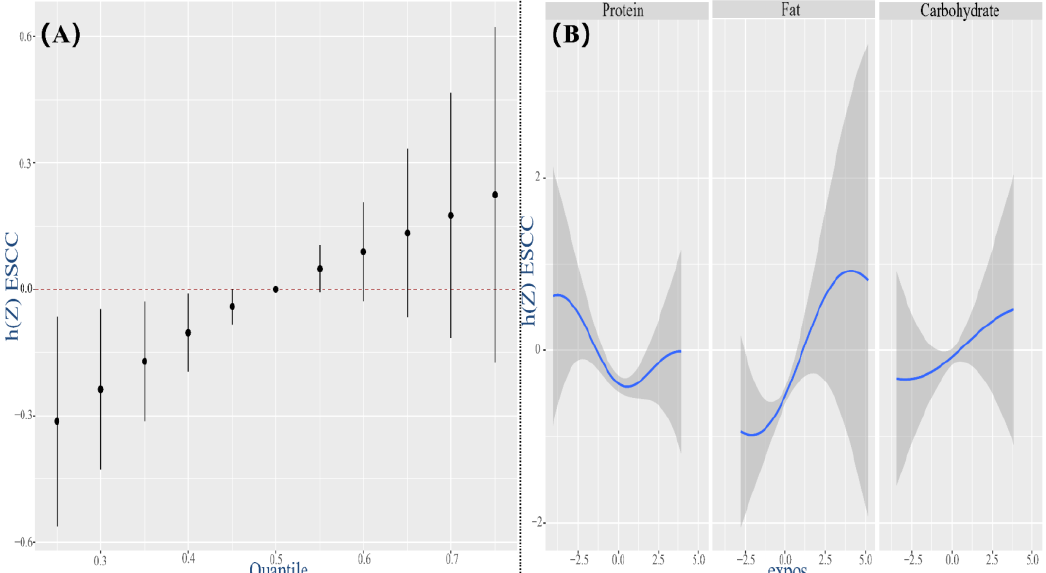
Figure 4. Associations between three pro−inflammatory nutrients (predictors) and ESCC (outcome) by BKMR model adjusting for age, gender, education, income, occupation, tobacco smoking, drinking intensity, tea consumption, eating speed per meal and hot food. ( A ) The estimated overall effect of 13 dietary nutrients as compared to when all other nutrients are at the 50th percentile. The red dotted line means the reference level at which all of nutrients are fixed to their 50th percentile, to achieve interests of computing the overall effect of the mixture. ( B ) The univariate exposure–response function of each nutrient when setting the remaining nutrients at their median level. Abbreviation: BKMR, Bayesian kernel machine regression.